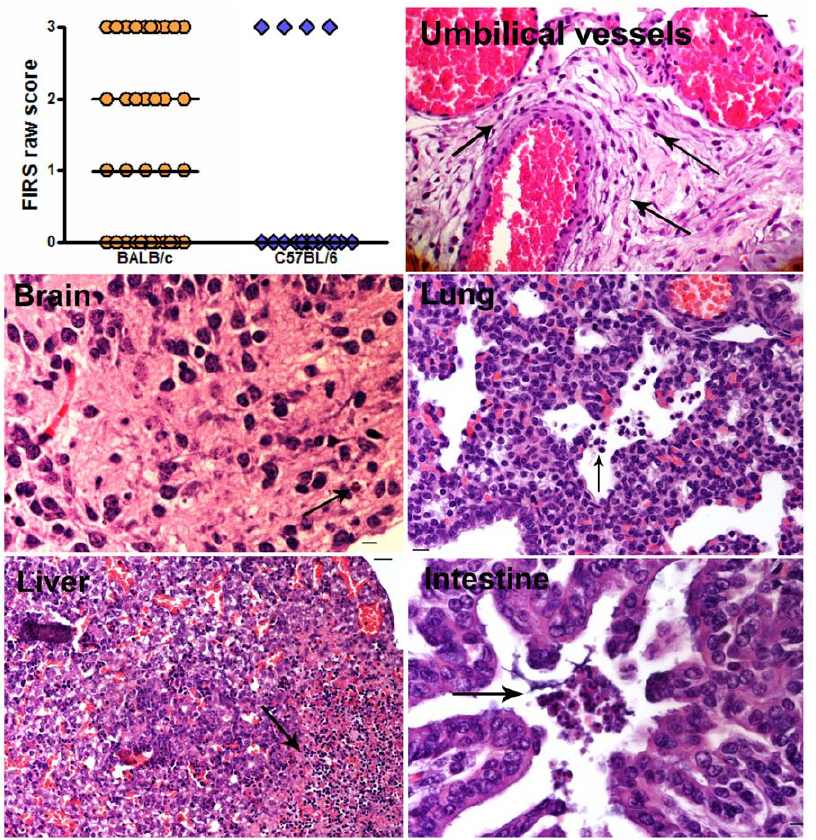
Figure 4. Fetal inflammatory response (FIR) in U.parvum infected BALB/c and C57BL/6 mice. Distribution of raw FIR scores as described in Table 2. Median scores are demarcated with a horizontal line in each graph. Data are a compilation of 3 independent experiments. Accompanying H & E stained sections are representative images of fetal pathology in umbilical vessels, brain, lung, liver, and intestine. Scale bar is equivalent to 100 m m. Arrows are highlighting neutrophilic